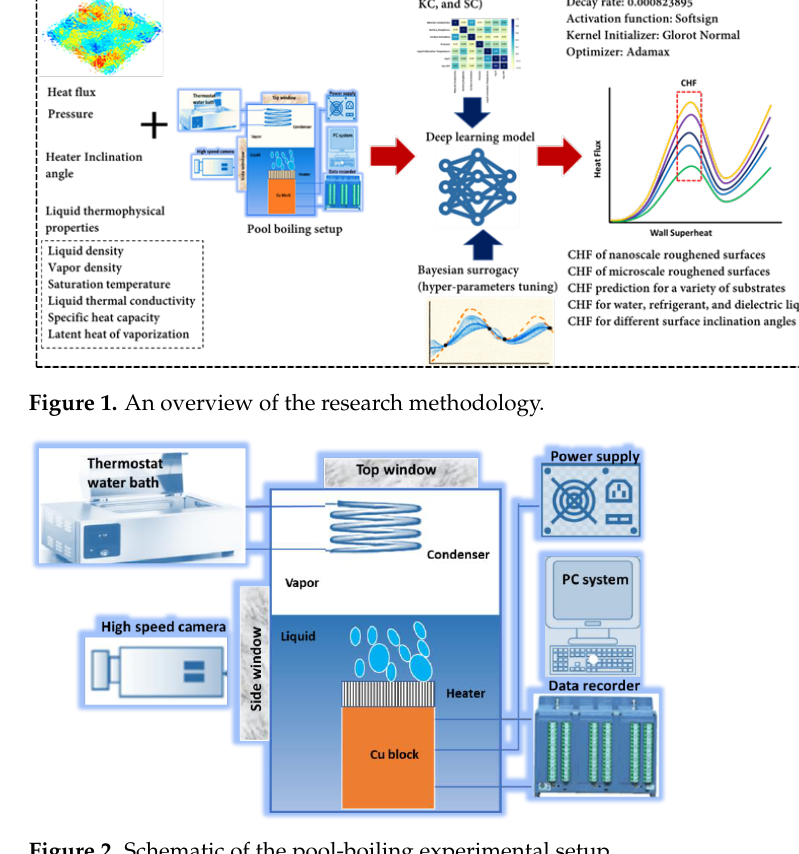
Figure 2. Schematic of the pool-boiling experimental setup.